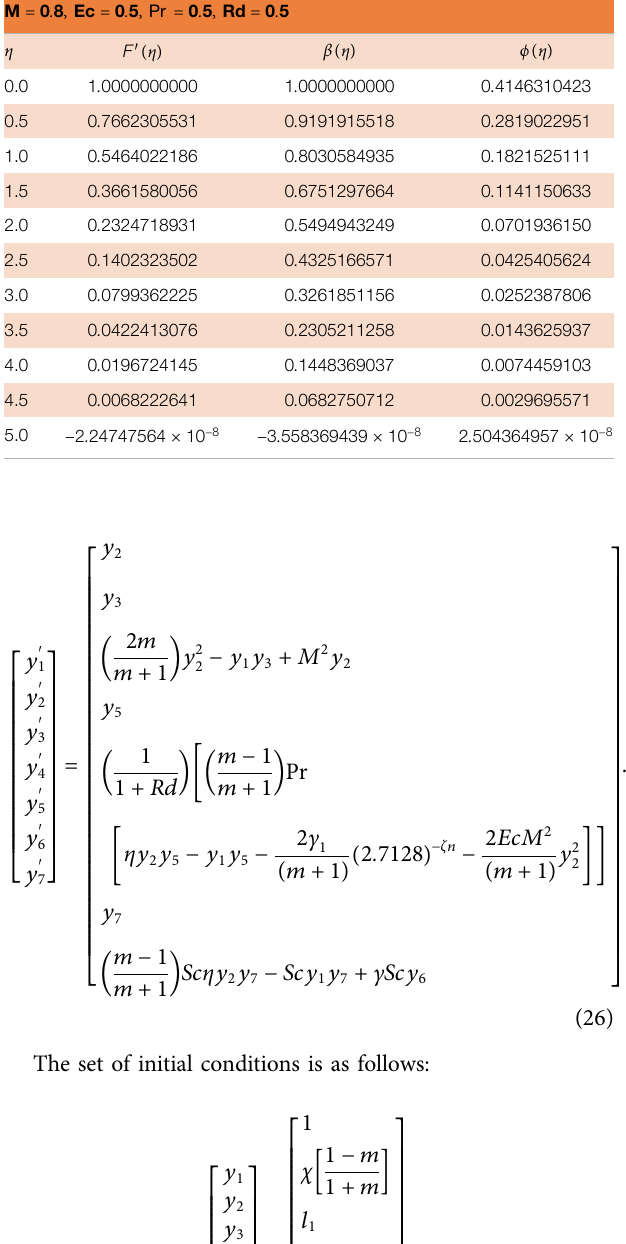
TABLE 1 | Numerical solutions for the velocity, temperature, and concentration fi